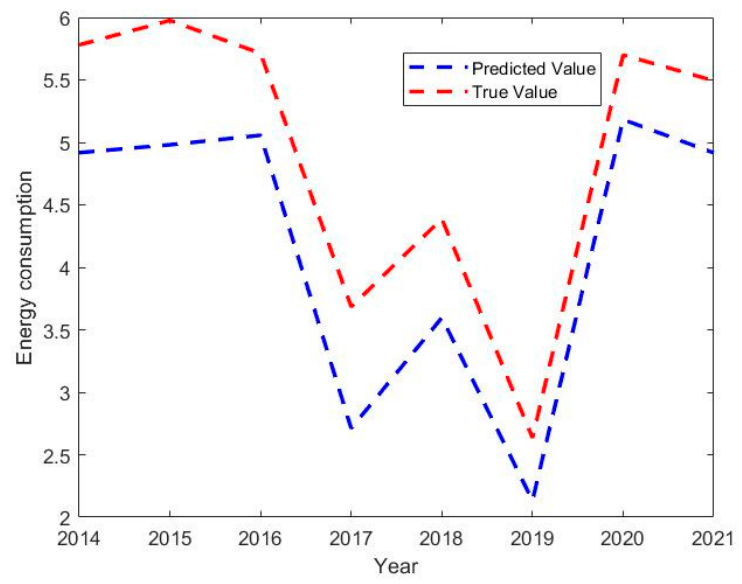
Figure 5. Model prediction results.